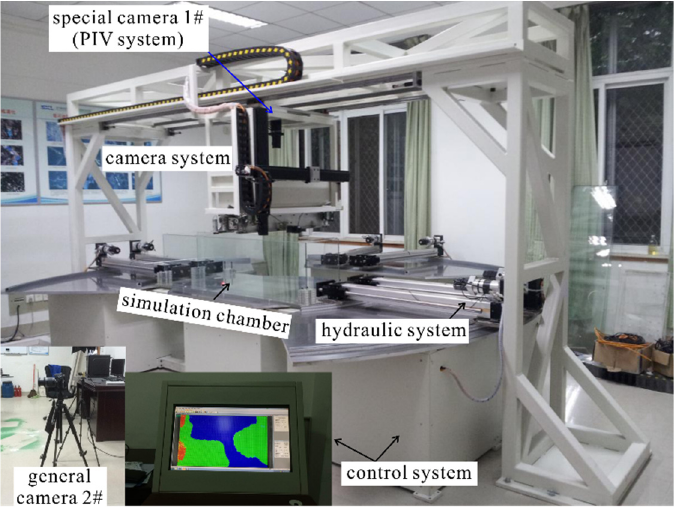
Figure 1. The comprehensively experimental platform for physical simulation of geological struc- tural deformation.